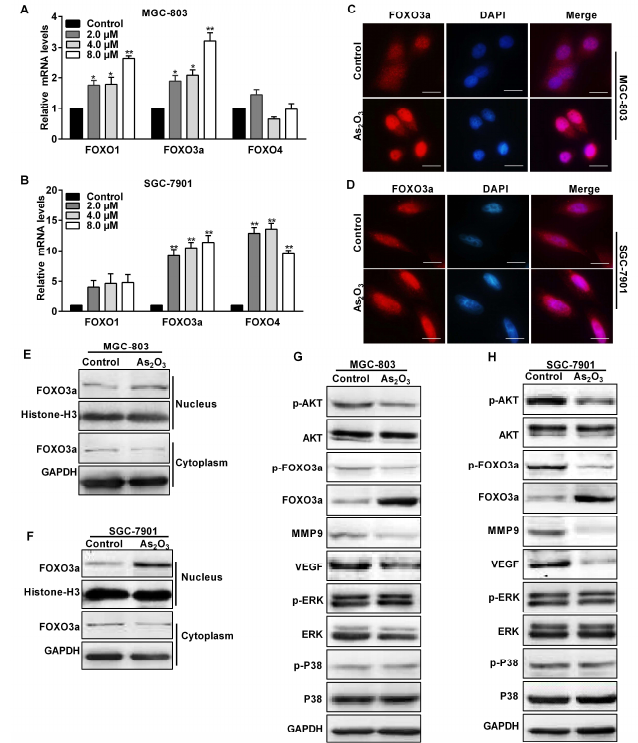
Figure 2. As 2 O 3 distinctly upregulated the expression of FOXO3a in the nucleus to regulate signal associated proteins. ( A , B ) qRT-PCR analyses showed FOXO transcription factor family mRNA expression levels. Average FOXO1, FOXO3a, and FOXO4 mRNA levels were normalized to GAPDH. ( C , D ) Representative immunofluorescence images showed FOXO3a expression was mainly in the nucleus (red light). Cell nuclei were labelled with DAPI. Scale bar, 5 μm. ( E , F ) Western blotting analysis showed the expression of FOXO3a in MGC-803 and SGC-7901 cells treated with As 2 O 3 . FOXO3a in the cytoplasm and nucleus were extracted, respectively. ( G , H ) Protein levels of p-AKT, AKT, p-FOXO3a, FOXO3a, VEGF, MMP9, p-ERK, ERK, p-P38, and P38 were detected by western blotting analysis. The whole cell lysate protein was extracted from these cells treated with As 2 O 3 for 24 h. Compared with the control group, * p < 0.05, ** p <